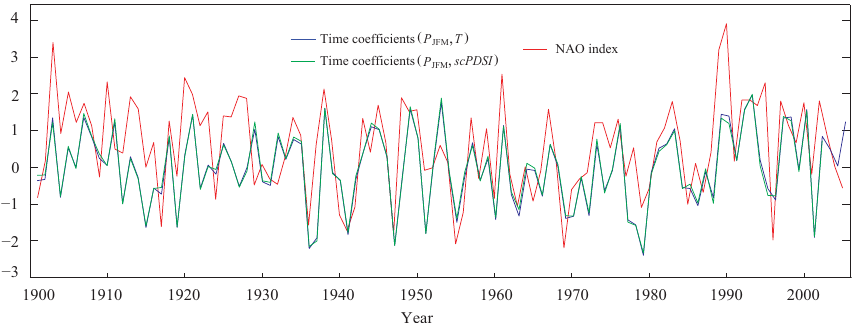
Fig. 3. The MCA time coefficient series and the NAO index. One blue line is used to plot the highly correlated time coefficient series ( r > 0.99) from T mean and T max analyses. Green line indicates time coefficient series from the scPDSI analysis. The red line is the averaged NAO index in